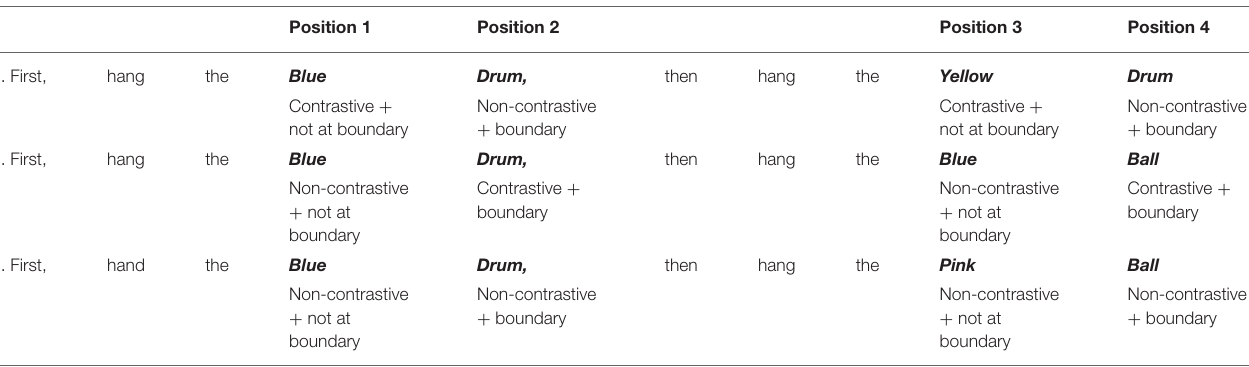
TABLE 4 | Sample sentences with contrastive and non-contrastive information at different